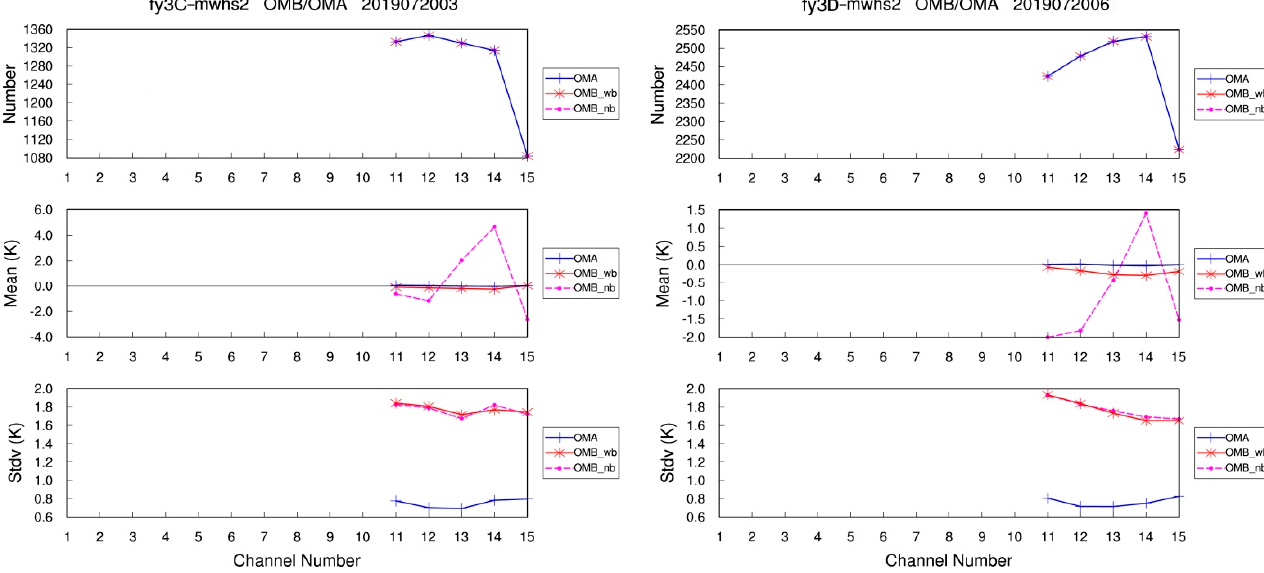
Figure 4. The statistics of observation number, background departure and analysis departure for each channel of MWHS-2 on satellite FY-3C (left) at 0300 UTC and FY-3D (right) at 0600 UTC 20 July 2019, respectively.